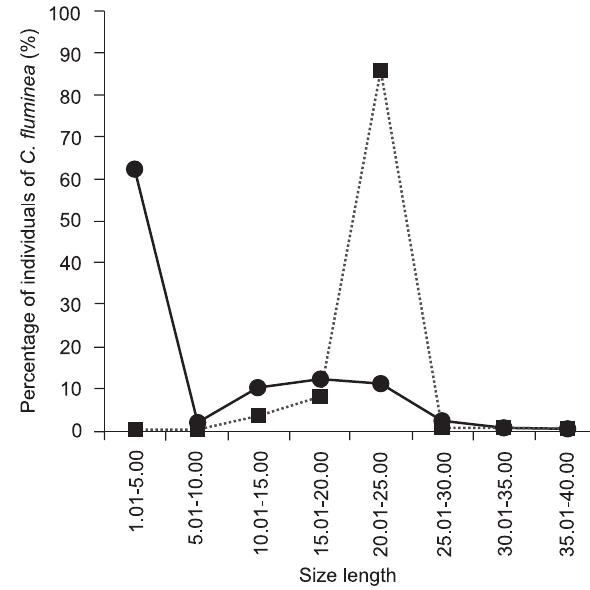
Figure 3. Comparison of the size distribution between the values of Darrigran and Maroñas (1989) (  ) and 2015/2016 ( 